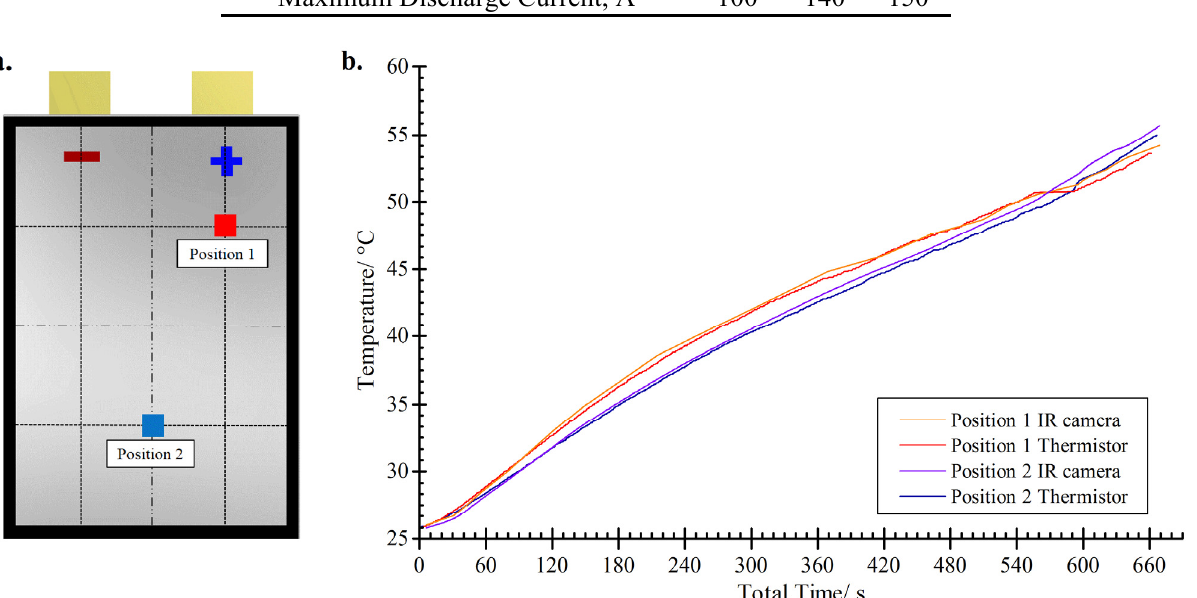
Figure 1. ( a ) Two locations on the cell surface subjected to measurement comparison; ( b ) Temperature profile measured by the IR camera and the thermistor at the corresponding locations of the cell surface during a discharge at 100 A of an NMC, 20 Ah